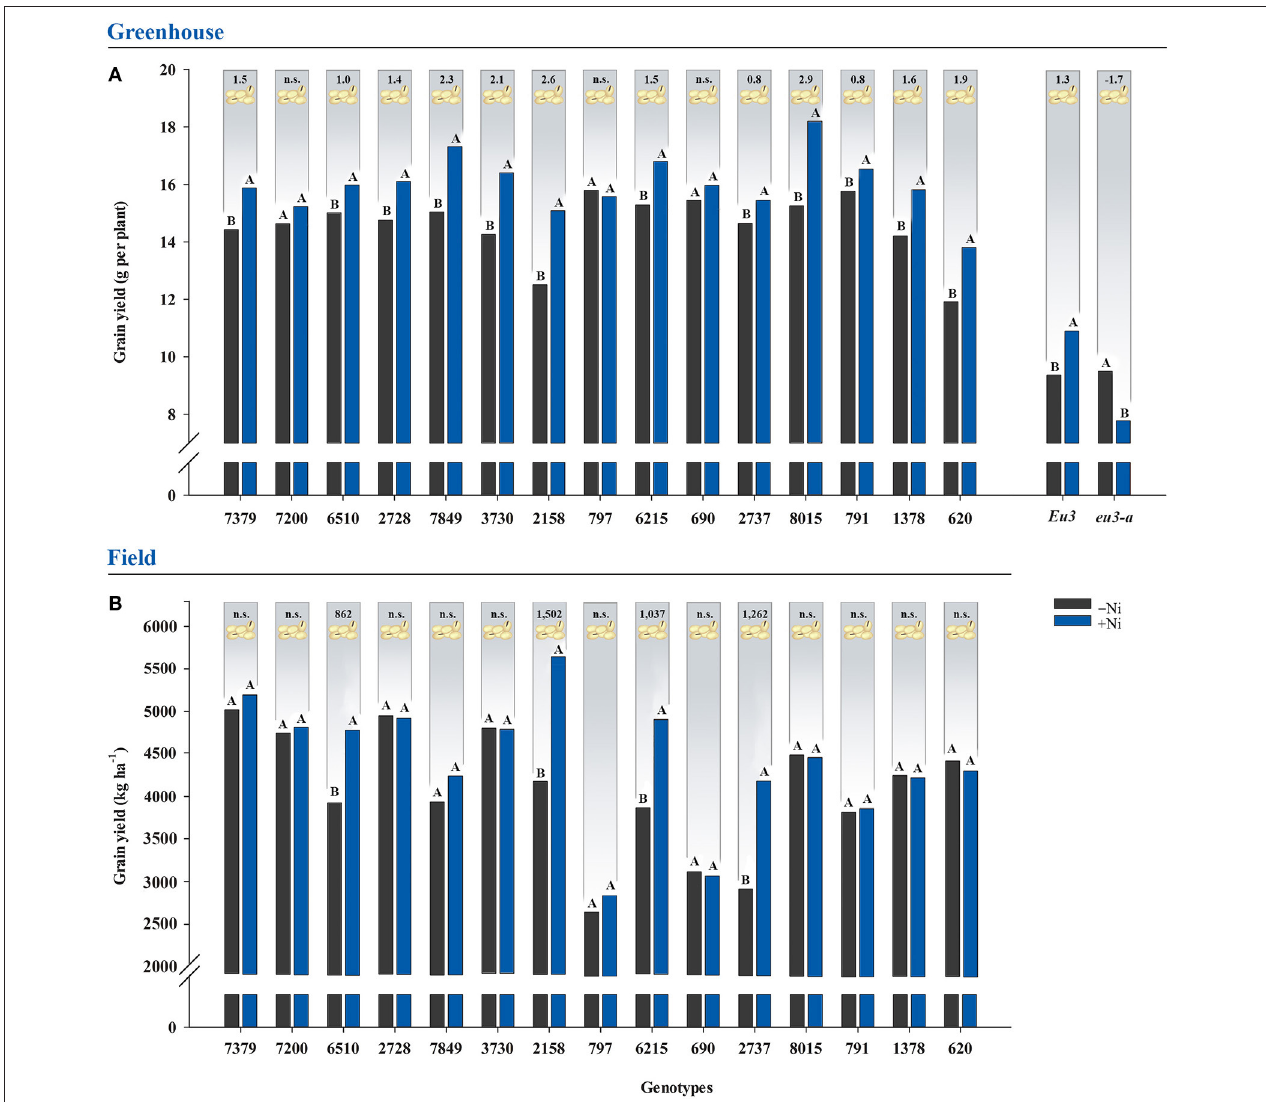
FIGURE 1 | Effects on grain yield due to fertilization with 0.0mg of Ni kg − 1 ( − Ni) and 0.5mg of Ni kg − 1 ( + Ni) in 15 soybean genotypes and two near-isogenic lines (NILs, Eu3 and eu3-a ) cultivated in (A) greenhouse and (B) field conditions. Means were compared by the effect of the Ni doses in each genotype by Dunnett’s test at P < 0.05, and those followed by the same letter do not differ. Values indicated in the upper part of the figure correspond to the amplitude of difference between Ni doses in grain yield. Grain yield was corrected to 13% of moisture. n.s., not significant. The NILs were not tested in the field